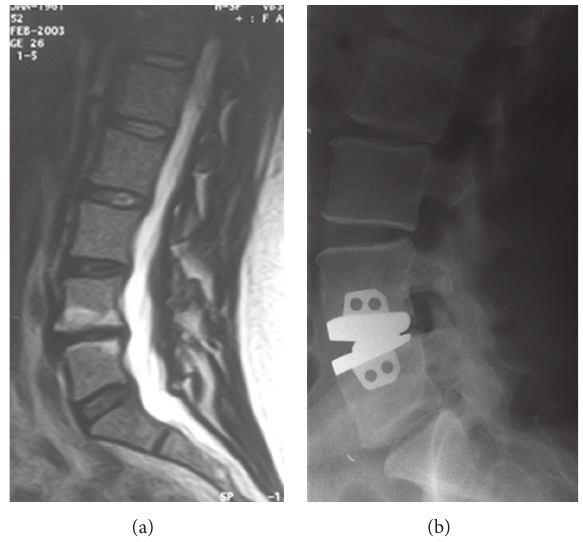
F 1: A 30-year-old woman complained of severe back pain attacks. She had no neurological de�cits. (a) T2-weighted MRI scans showed advanced degeneration with Modic changes in the L4-L5 disc. (b) Maverick disc prosthesis was